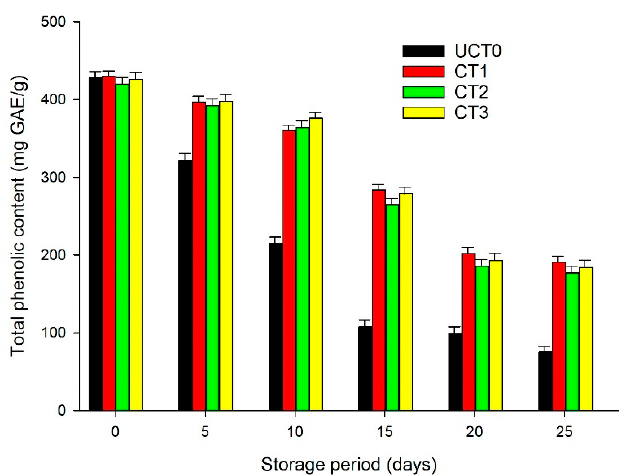
Figure 4. Behavior of total phenolic content (mg GAE/g) of Golden Delicious apple slices coated (with CT1, CT2, and CT3), and not treated (UCT0) at day 0, and after 5, 10, 15, 20, and 25-days of storage at 4 °C in dark conditions and 85% relative humidity (RH). Values indicate the means ± standard deviations ( n = 3). Abbreviations: UCT0, uncoated apple slices used as control; CT1, apple slices coated with chitosan-glycerol-cinnamon oil; CT2, apple slices coated with guar gum-glycerol-cinnamon oil; CT3, apple slices coated with composite guar gum-starch-glycerol-cinnamon oil.